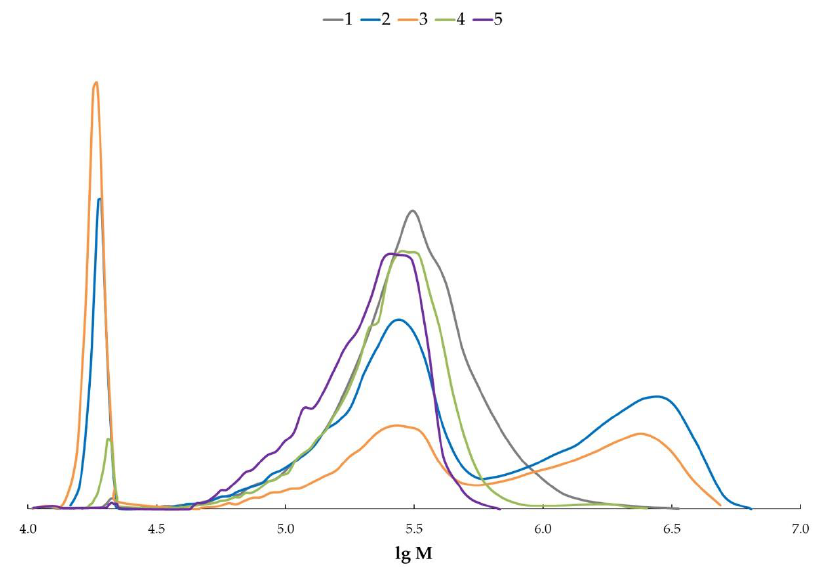
Figure 3. MWD curves of ( 1 ) gelatin; graft Gel-PMMA copolymer synthesized in the presence of ( 2 ) AIBN, TBB, and 2,5-DTBQ; ( 3 ) AIBN and TBB; ( 4 ) AIBN; ( 5 ) TBB and 2,5-DTBQ.